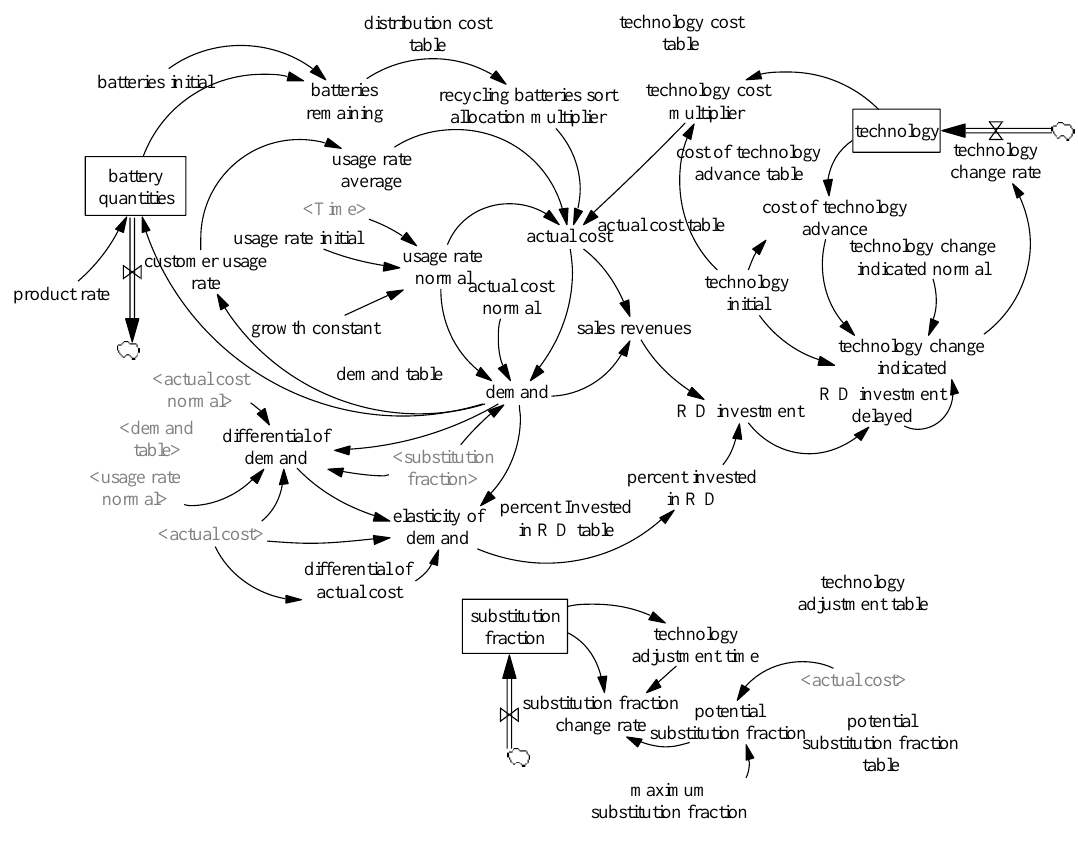
Figure 3. Stock flow diagram.